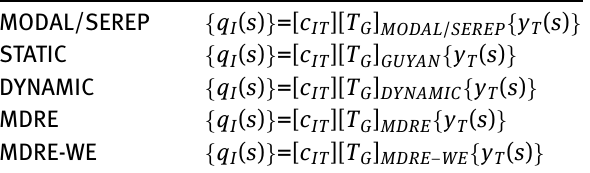
Table 1: Operator [ T G ] using different model order reduction meth- ods applied to mode shape expansion